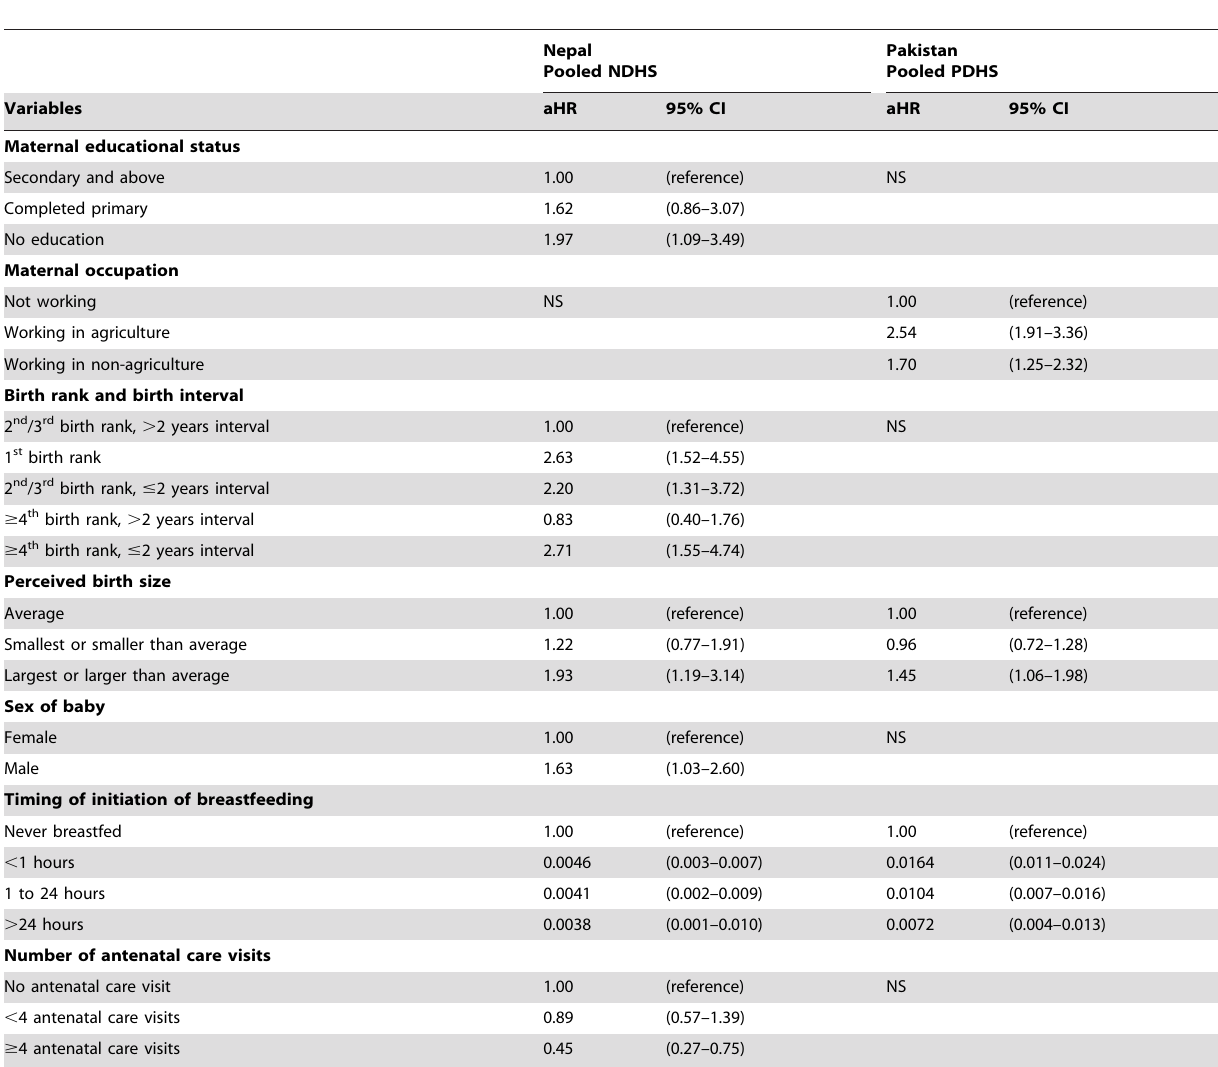
Table 3. Adjusted hazard ratios (95% CI) for early neonatal mortality for community-level and socioeconomic, maternal and newborn characteristics and perinatal health service determinants in Nepal and